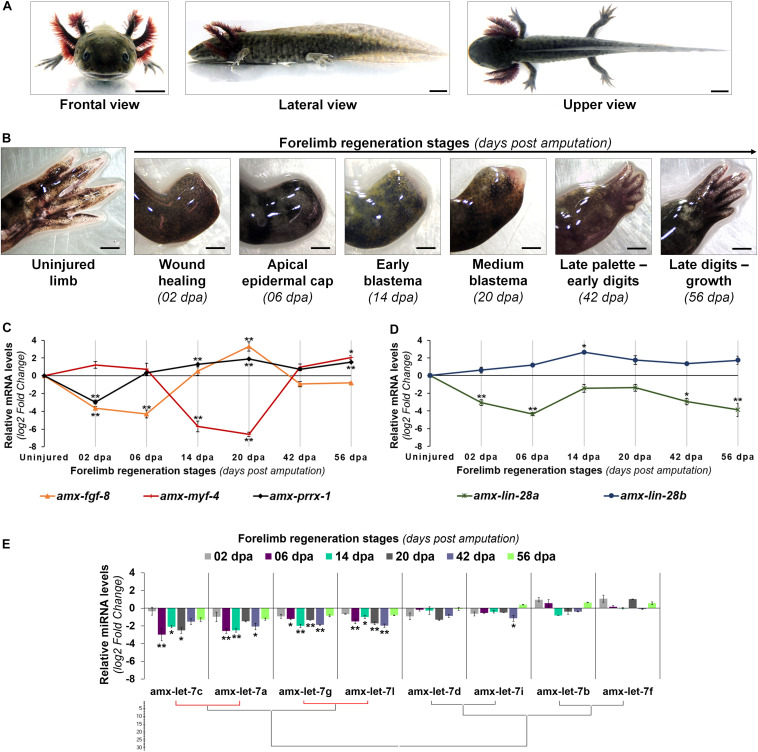
Transcriptional profiles of Lin28 factors and mature let-7 microRNAs during forelimb regeneration. (A) Morphological features of a late juvenile axolotl (14-16 cm snout-tail length) from different views. Scale bars: 1 cm. (B) Temporal and morphological characterization of the forelimb regeneration stages analyzed in late juvenile axolotls. Scale bars: 1 mm. (C) Transcriptional expression profile of some genetic markers during limb epimorphosis. (D) Relative abundance of lin-28 transcripts during epimorphic regeneration. (E) Maturation patterns of the let-7 family across regeneration. Hierarchical clustering was made with the Ward algorithm and a Manhattan distance measure, indicating in red a positive Pearson correlation of P < 0.05. Data in the graphs are represented as mean ± s.e.m. (n = 3); *, P < 0.05; **, P < 0.01; one-way ANOVA with post hoc Tukey–Kramer test vs uninjured condition.